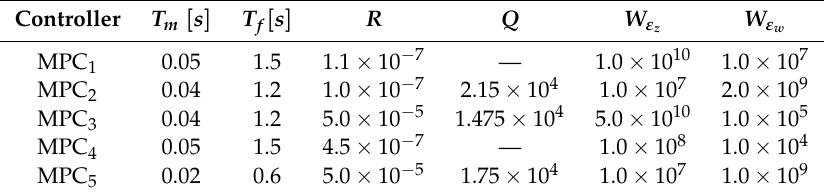
Table 7. Control parameters set for the sea state recorded in Table